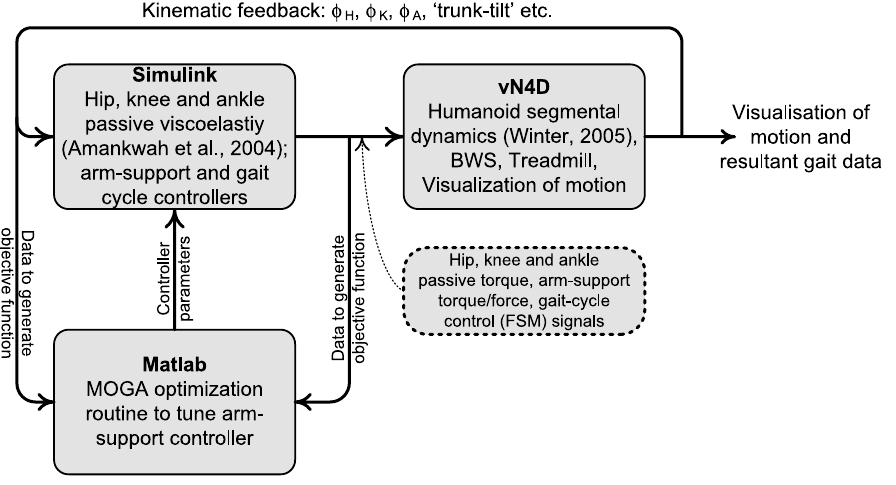
Fig. 3. Simulation environment schematic. ϕ H , ϕ K and ϕ A are hip, knee and ankle angles respectively. increased safety for the subject [15] would still